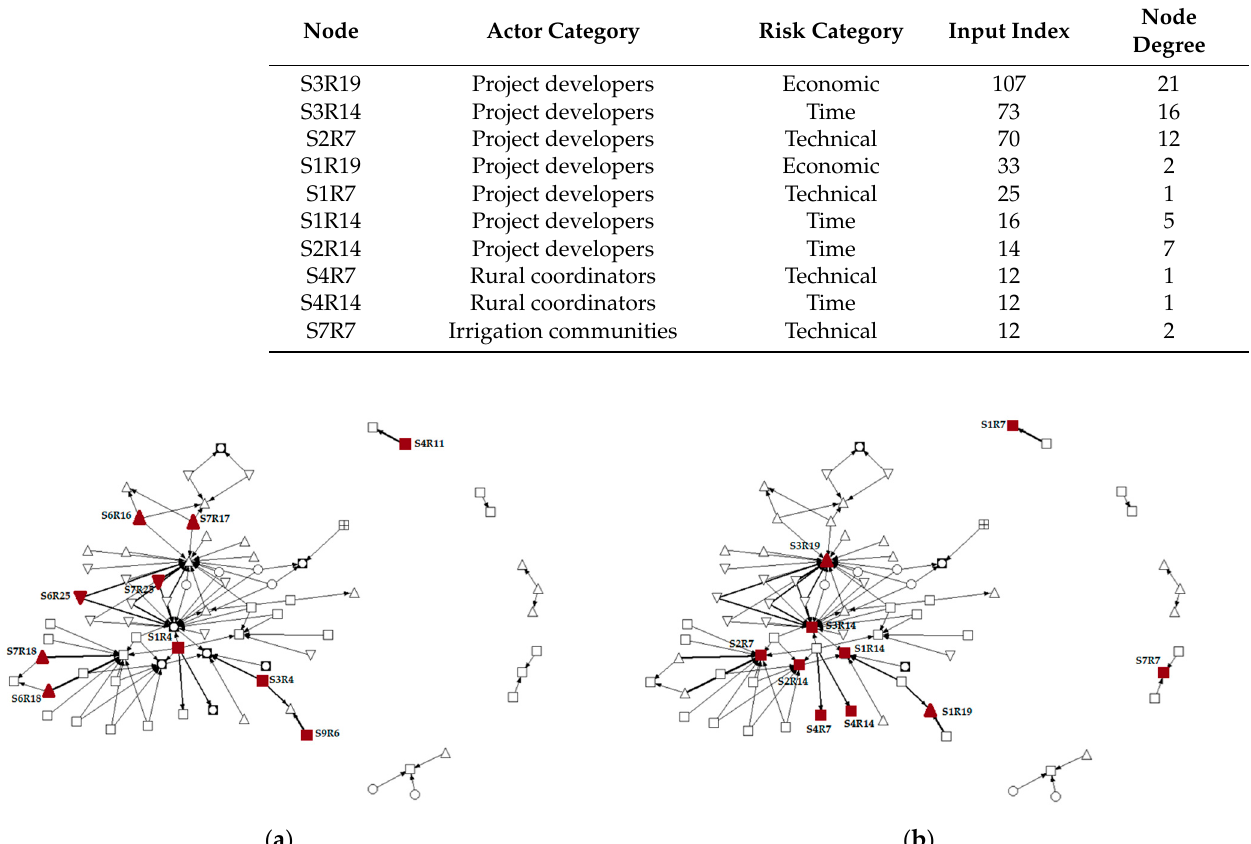
Table 6. Centrality results by input index.